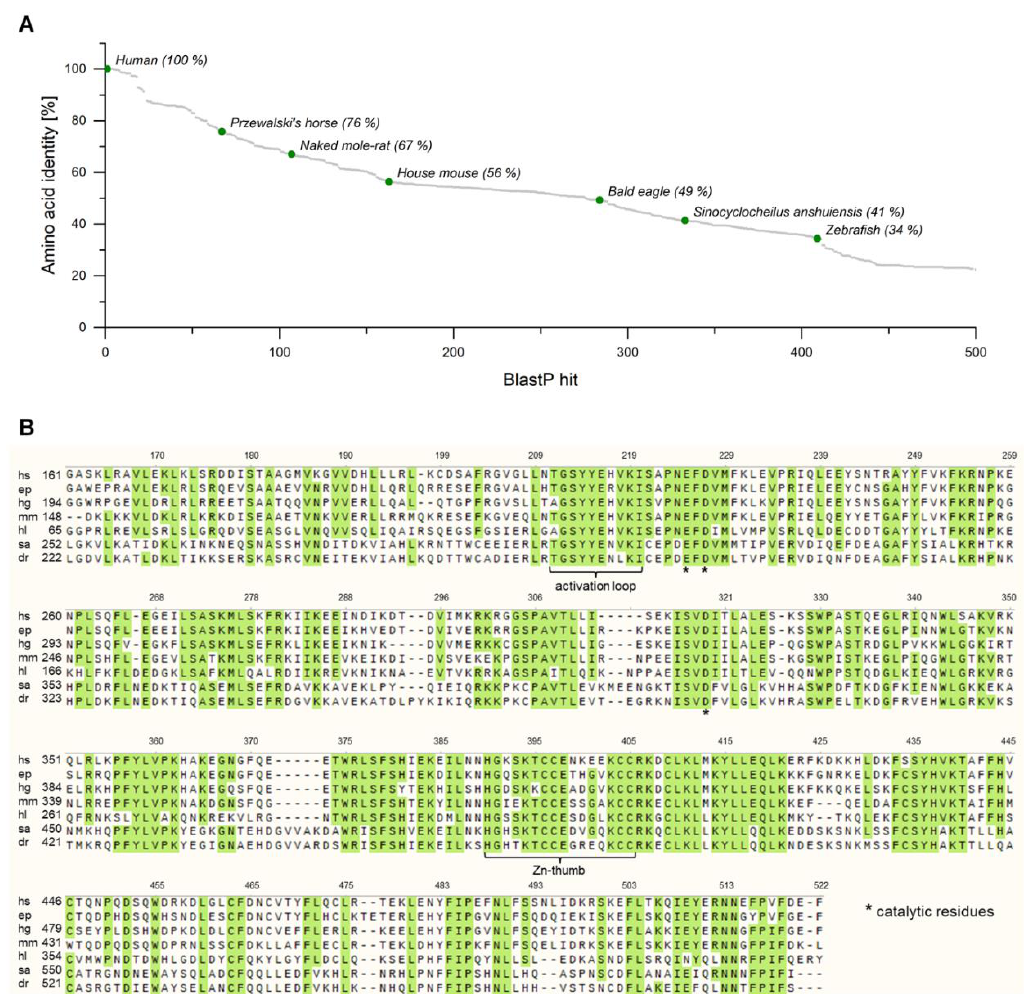
Figure 2. (A) BlastP analysis of truncated human cyclic GMP-AMP synthase (cGAS). (B) Multiple sequence alignment of truncated amino acid sequences of human (hs), Przewalski’s horse (ep), naked mole-rat (hg), house mouse (mm), bald eagle (hl), Sinocyclocheilus anshuiensis (sa), and zebrafish (dr) cGAS. For epcGAS, no information about the full-length sequence is available. Green shading indicates a consensus sequence above a 75% threshold. Numbering above the sequences corresponds to that for hscGAS. The alignment was generated using MUSCLE (SnapGene ®® , GSL Biotech LLC, Chicago, USA, Version 4.3.10).